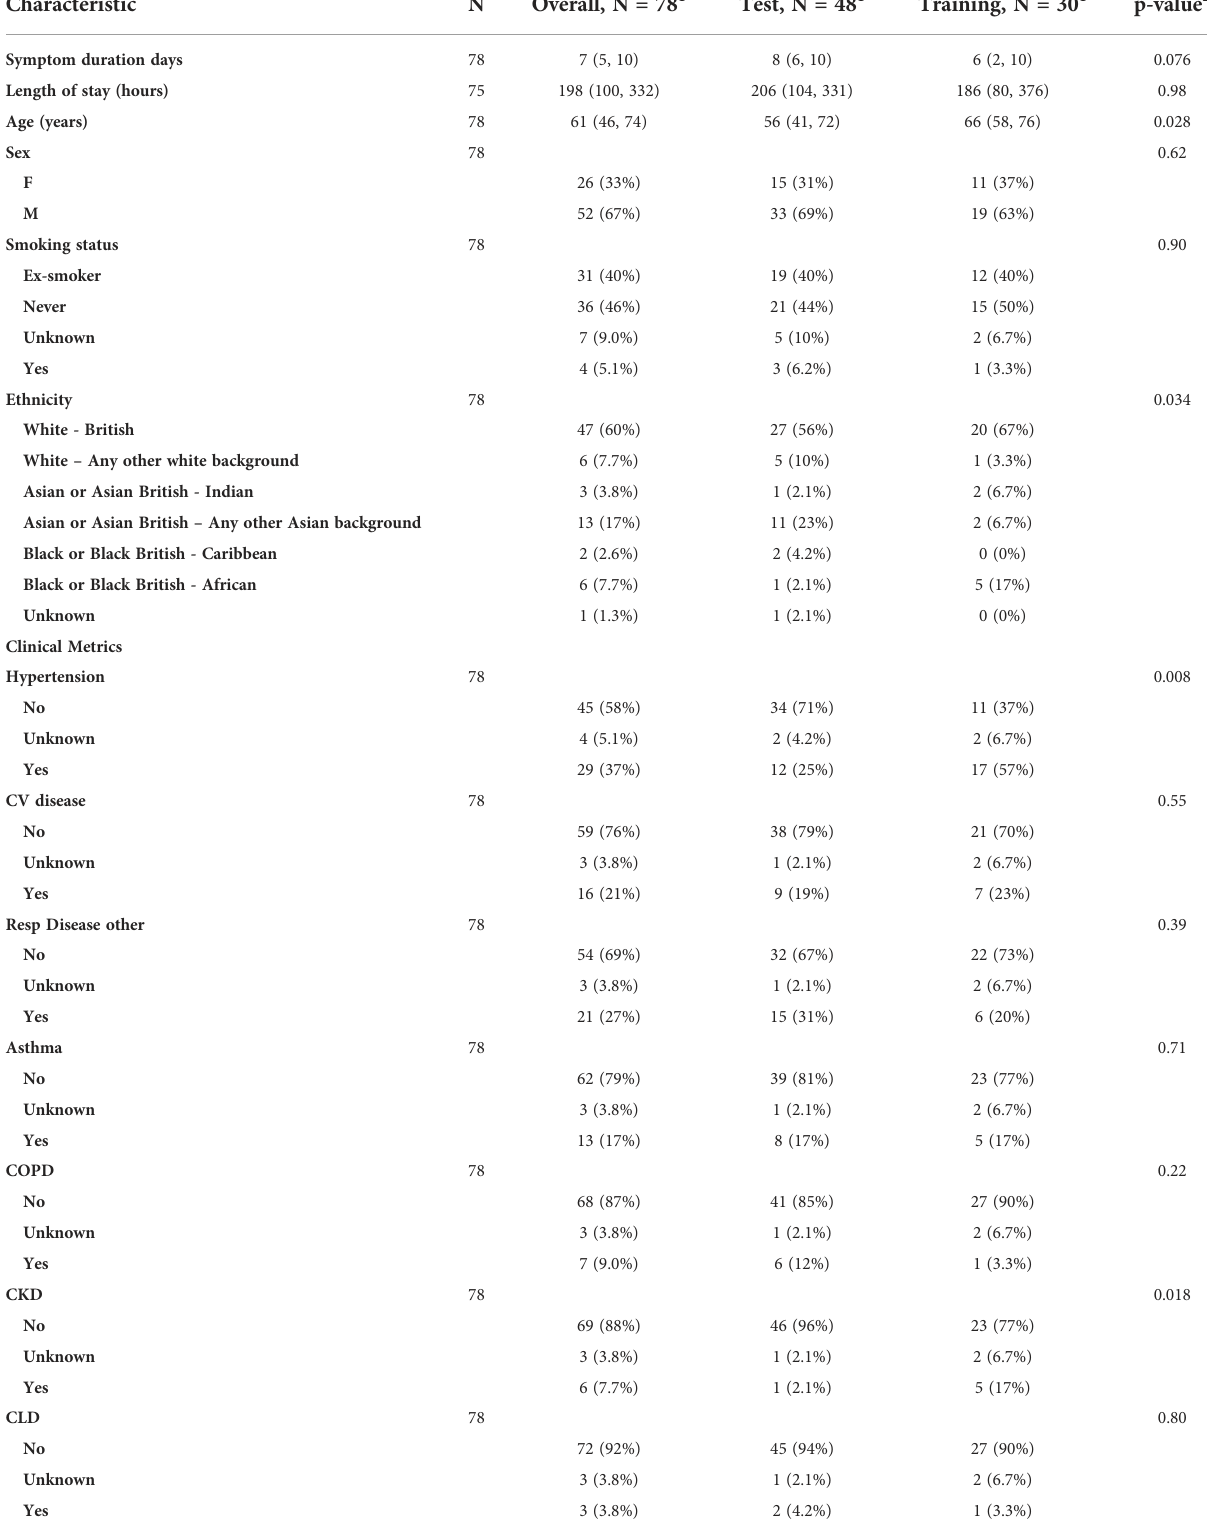
TABLE 2 Patient characteristics and demographics grouped by test or train